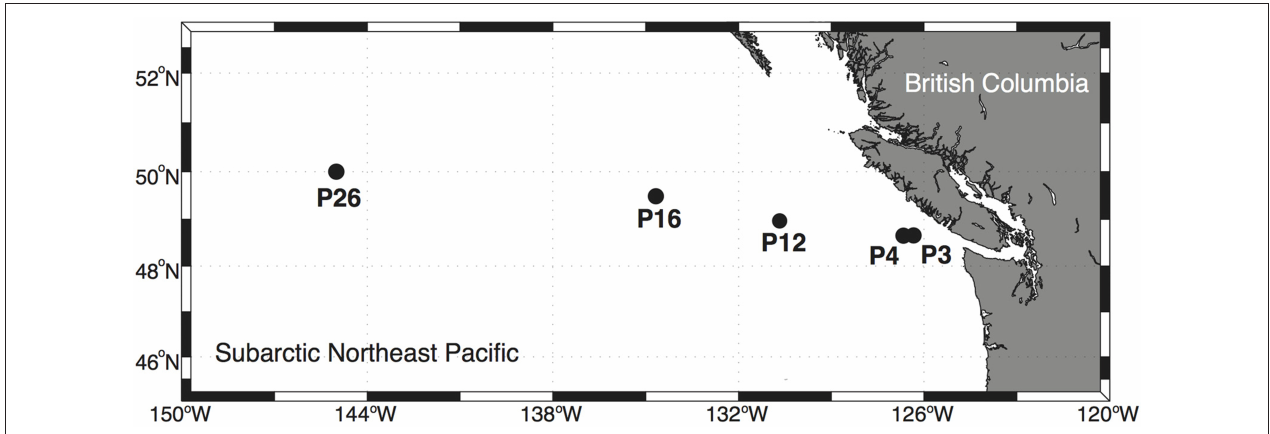
FIGURE 1 | Stations sampled along the Line P transect in the northeast subarctic Pacific